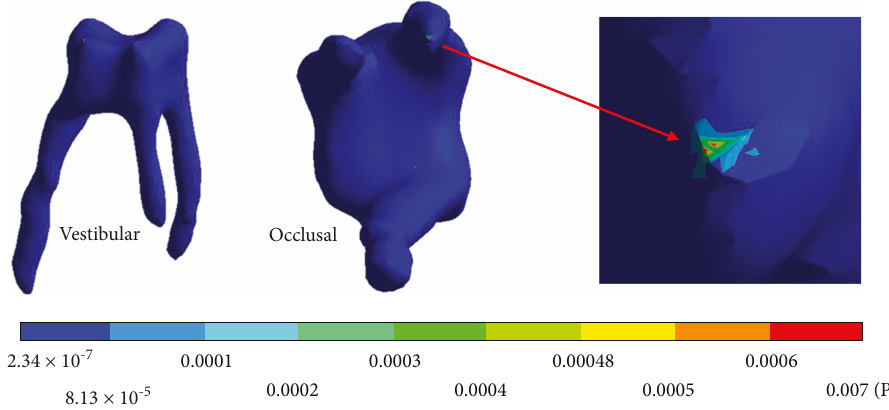
Figure 8: Control case: von Mises stresses in